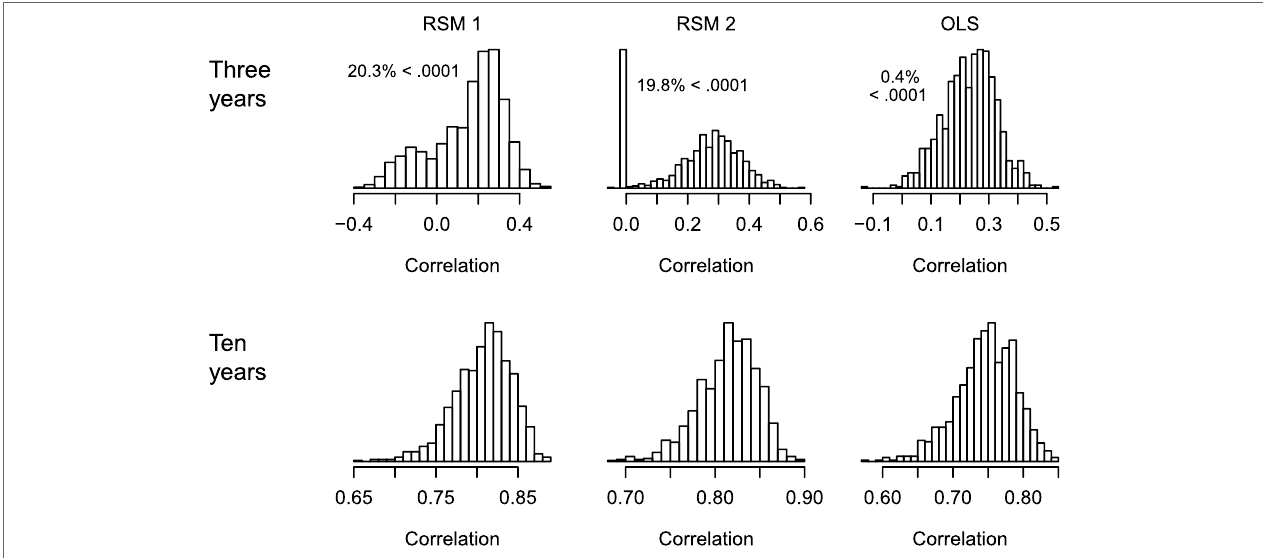
FIGURe 7 | Histograms of the correlations between the estimated and true underlying slopes for the different estimation methods when there are 3 and 10 years of data. Simulation 2 (negatively skewed). RSM 1 and RSM 2 refer to estimating the correlation between the random variables (1) and fixing it at zero